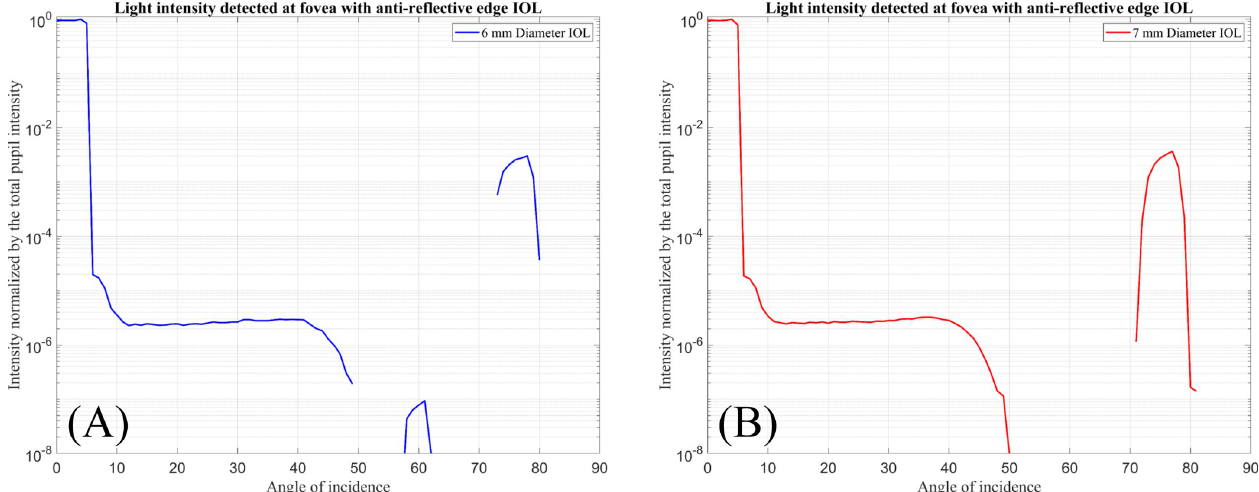
Fig 6. Normalised input intensity detected by Detector-F over the incident ray angle. (A) For 6 mm diameter IOL with anti-reflective edge surface. (B) For 7 mm diameter IOL with anti-reflective edge surface.